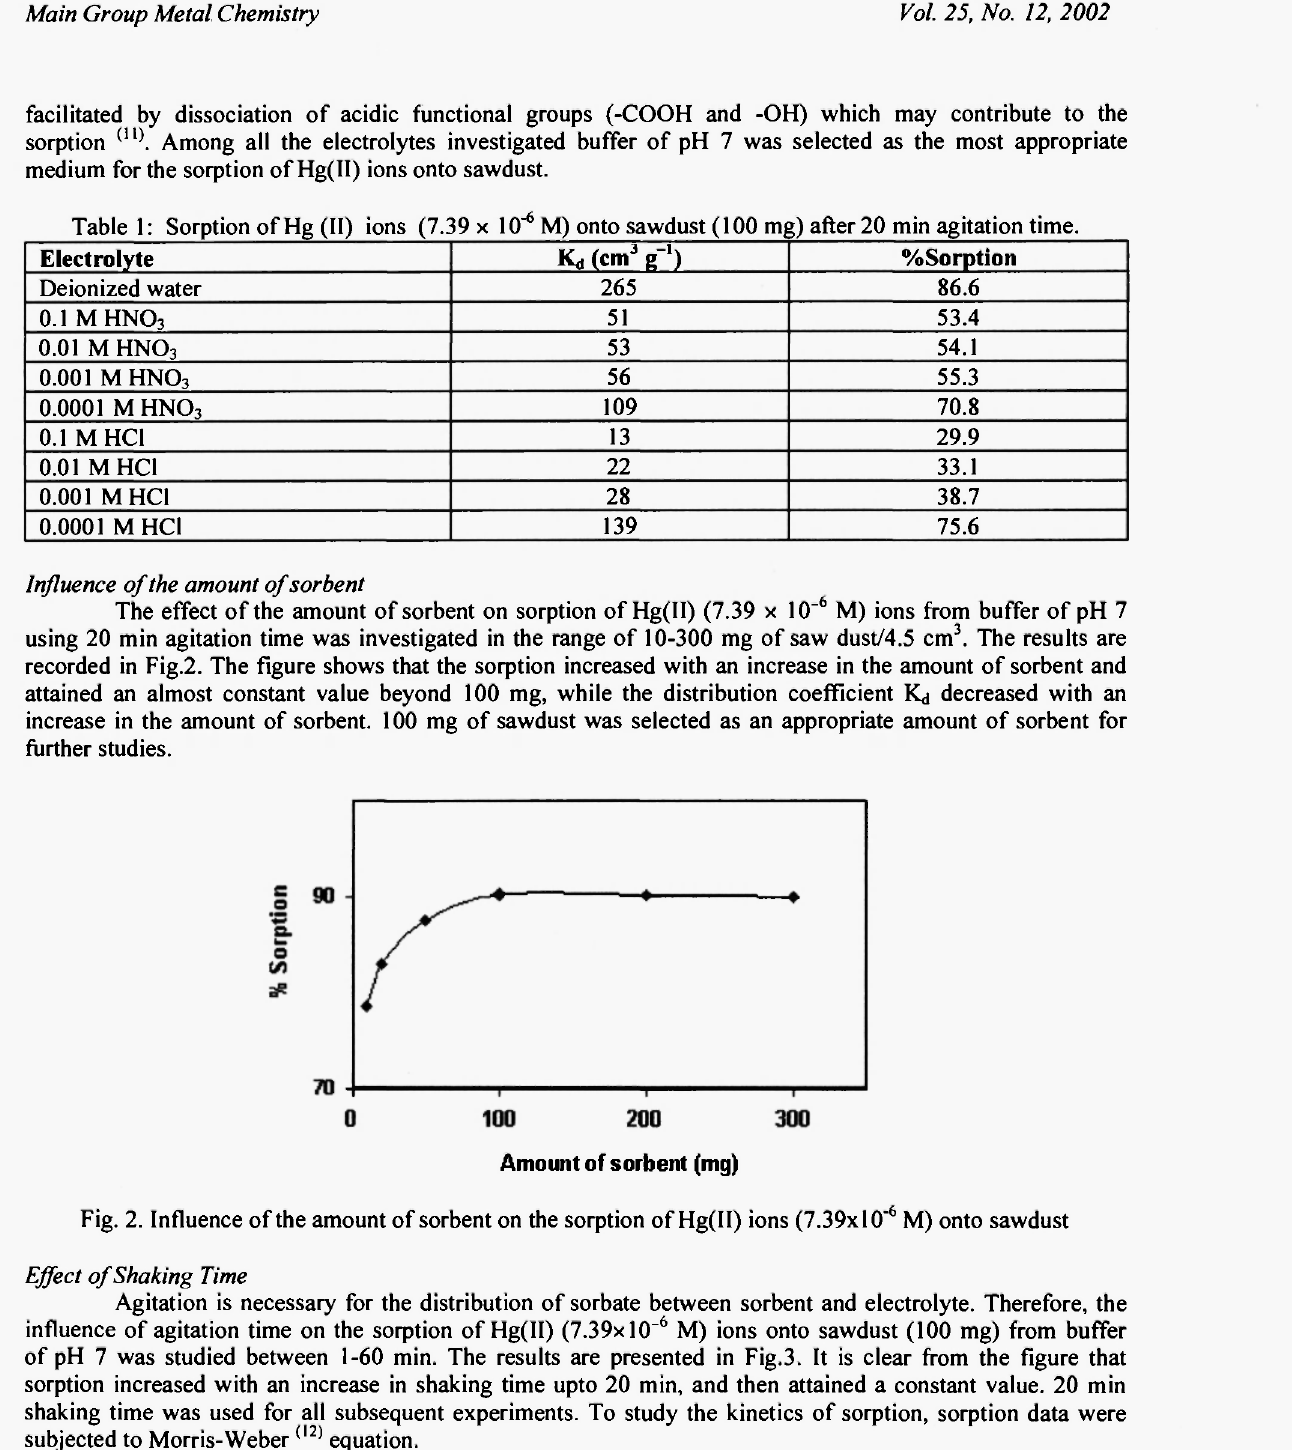
Fig. 2. Influence of the amount of sorbent on the sorption of Hg(II) ions (7.39xl0" 6 M) onto sawdust Effect of Shaking